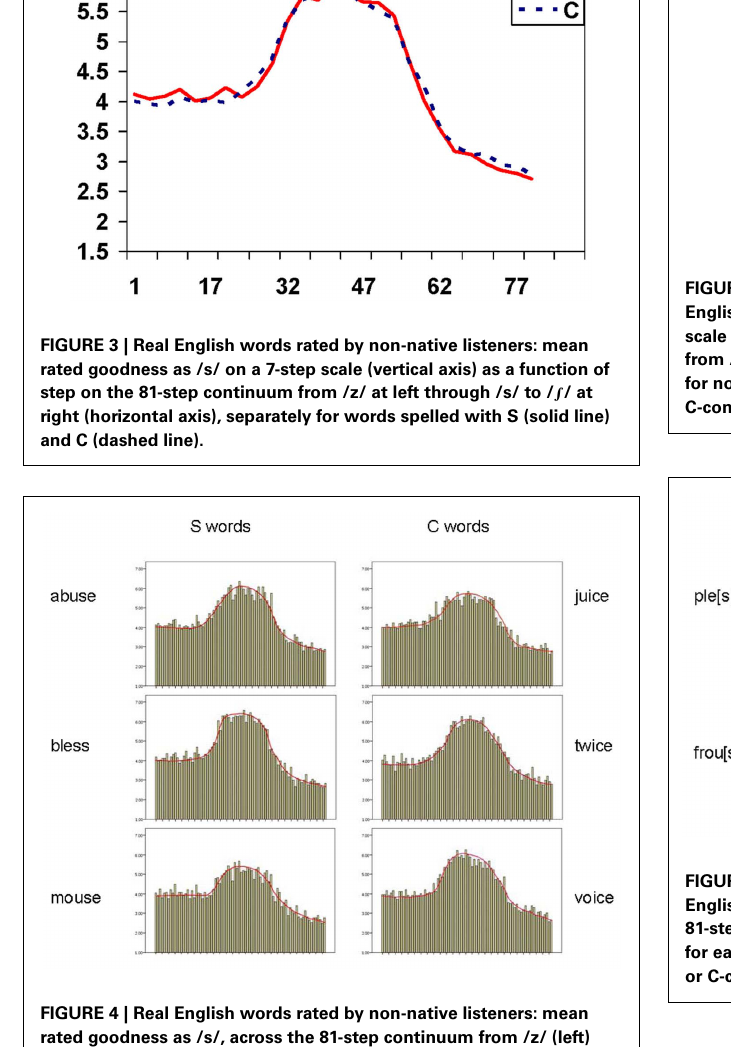
FIGURE 4 | Real English words rated by non-native listeners: mean rated goodness as /s/, across the 81-step continuum from /z/ (left) through /s/ to / ∫ / (right), separately for each word spelled with S (left column) or C (right column).